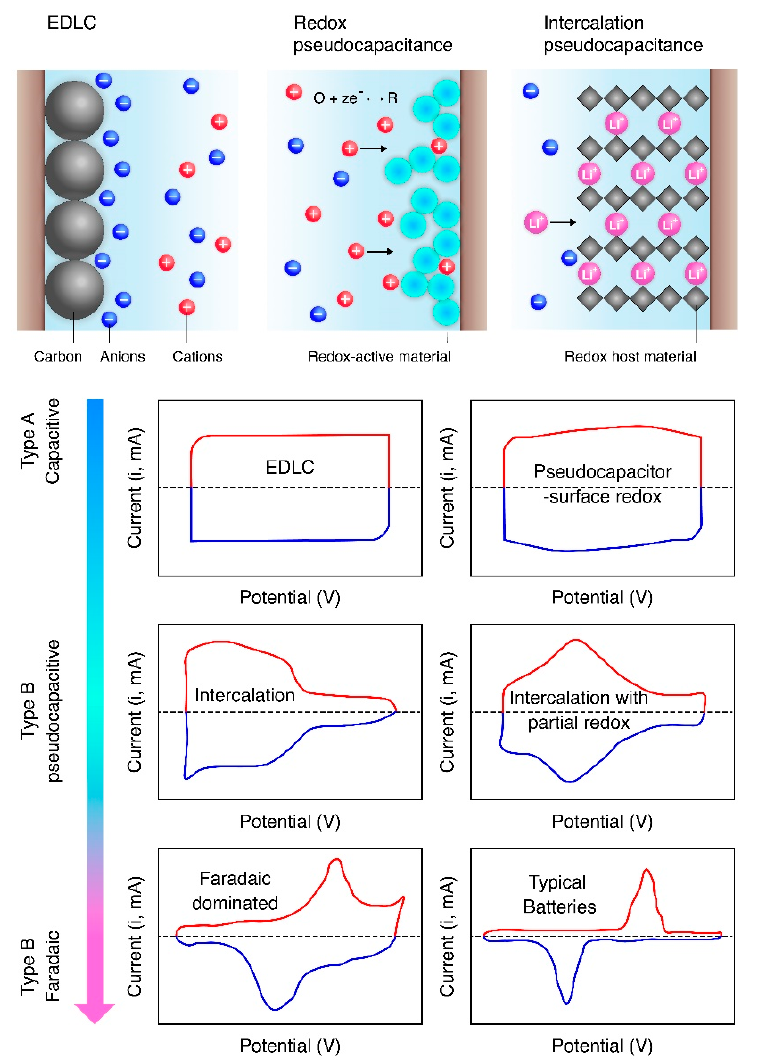
Figure 4. Schematic of ion intercalation: Li ions are intercalated within the interlayer spacing via chemical or electrochemical reactions. The crystals swell, leading to weak van der Waals interactions, agitation (i.e., ultrasonication, shear forces or thermal process) then results in the exfoliation of individual layers.